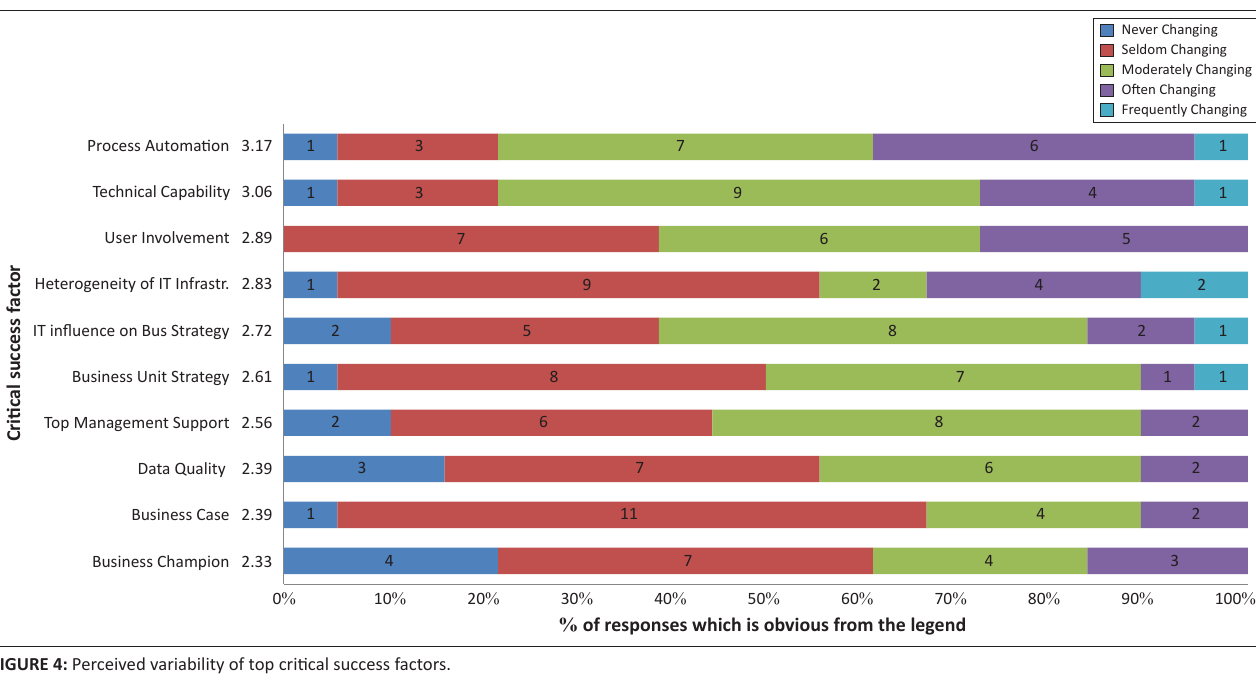
FIGURE 4: Perceived variability of top critical success